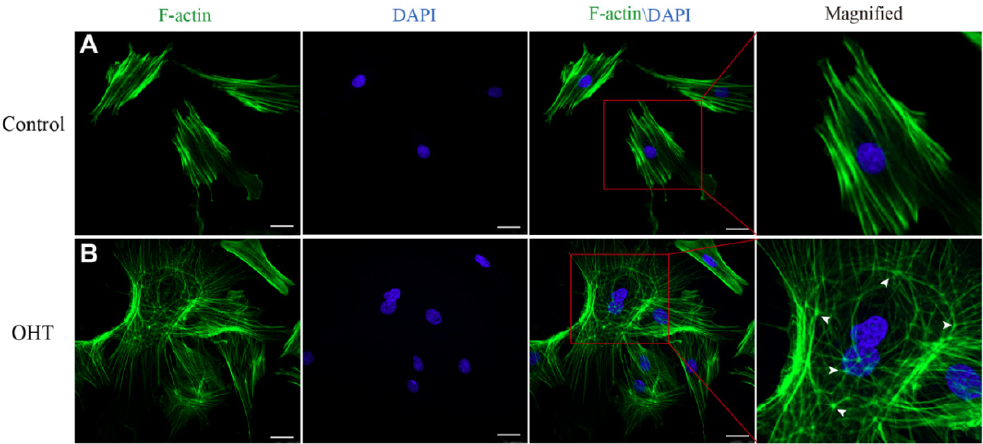
Figure 4. The cytoskeleton morphology of TM cells. For a clearer view, the cytoskeleton image of a single cell was enlarged. ( A ) The phalloidin staining images of cytoskeleton F-actin fibers (green) and nuclei (blue) in the control group, and ( B ) in the OHT group. F-actin fibers of TM cells in the control group were clear and arranged along the long axis, while those in the OHT group were crisscrossed and exhibited affluent thin filamentous pseudopods. The location of CLAN vertices was shown by arrowheads and observed with F-actin labeling. Scale bar: 25 µ